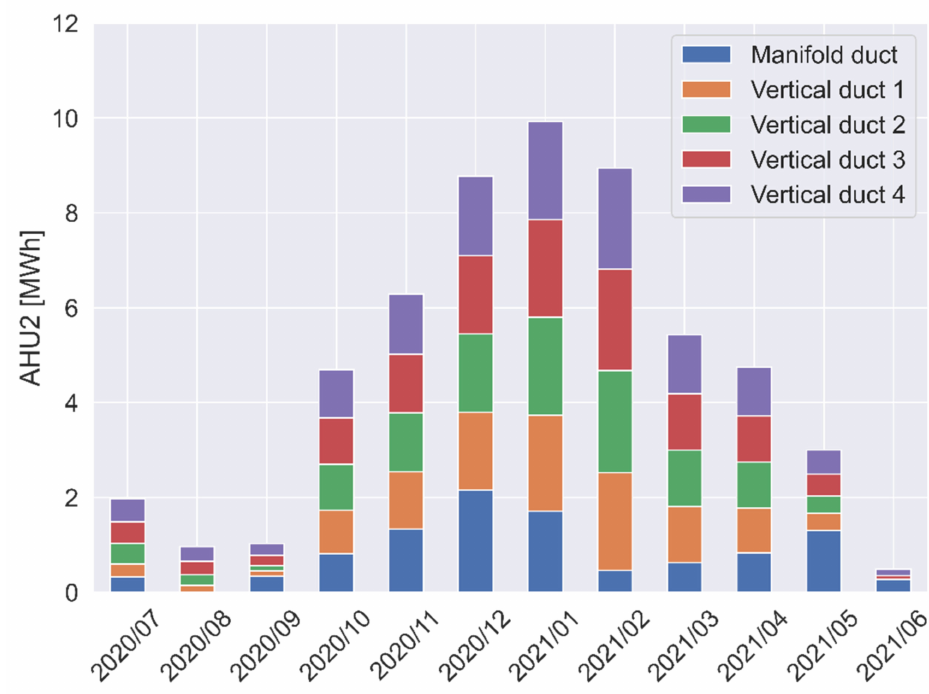
Figure 21. AHU1: monthly energy delivered by level.